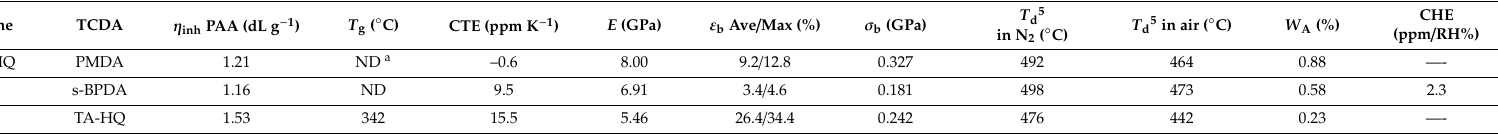
Table 2. Film properties of the PEsIs derived from AB-MHQ (R = –CH 3 ) with tetracarboxylic dianhydrides (TCDA).